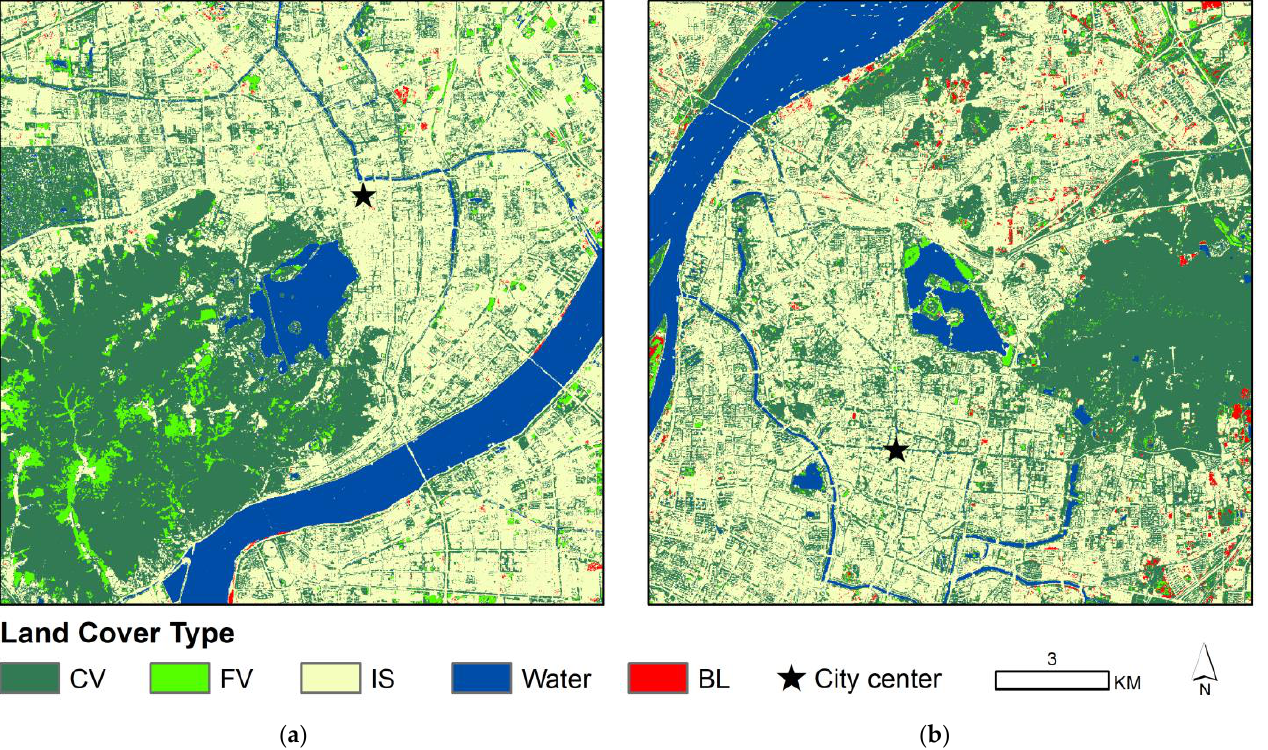
Figure 4. The land cover maps of ( a ) West Lake and its neighboring areas in Hangzhou, and ( b ) Xuanwu Lake and its neighboring areas in Nanjing (CV: coarse-textured vegetation; FV: fine-textured vegetation; IS: impervious surface; BL: bare lands; Water: water).